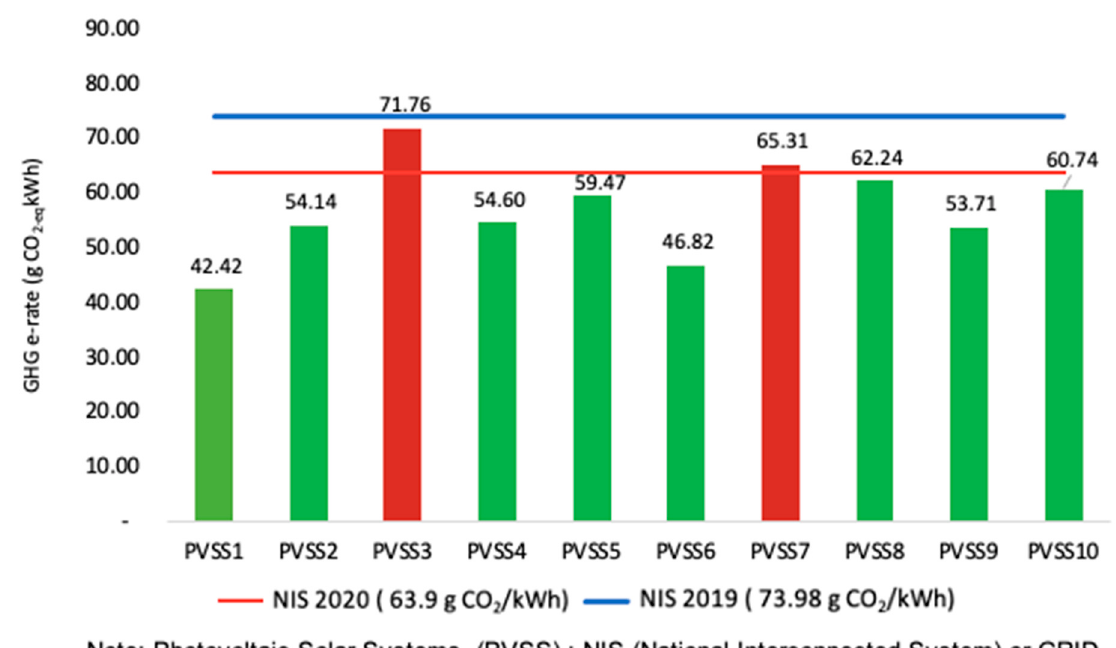
Figure 8. Comparison of the GHG rate results for PVSS in this study. Blue and red lines denote the emission factor of the Brazilian NIS of 2019 [11] and that projected for 2020 [10], respectively.